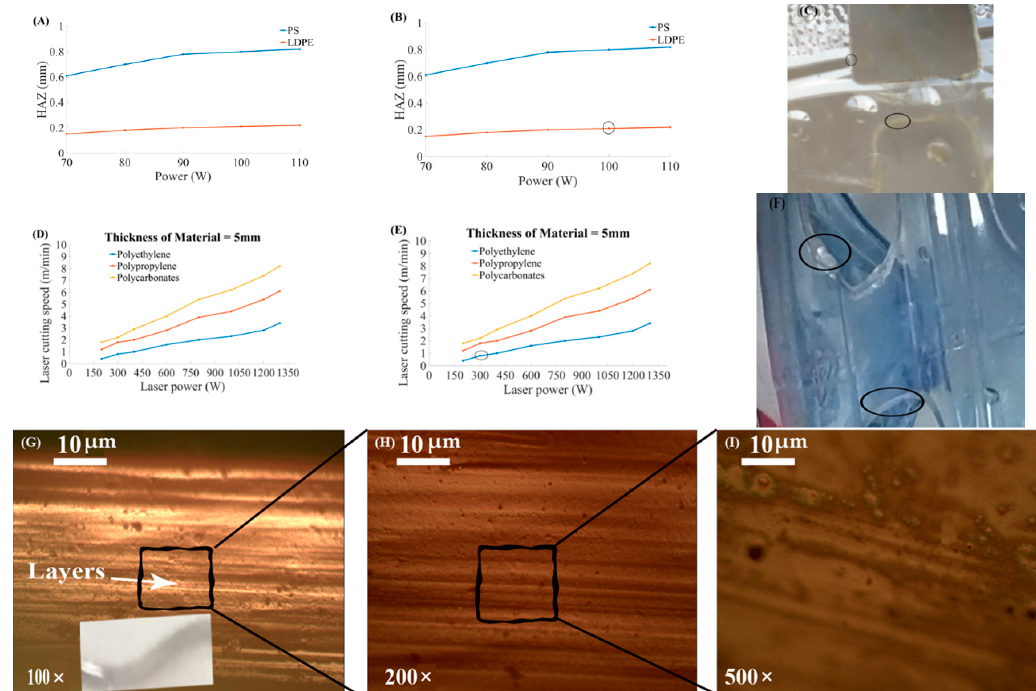
Figure 13. Parametric trends for P L and CS for PS, LDPE, PE, PP, and PC at different power ratings ( A ): Graphical illustration to show the influence of laser power on HAZ for PS and LDPE, ( B ) Indication of pointed part of ( A ), ( C ): Pictorial representation of one of the cut parts among PS and LDPE, ( D ): Relationship between laser power and cutting speed at same thickness of 5 mm for PE, PP, and PC, ( E ): Indication of pointed part from ( D ), ( F ): Pictorial representation of one of the cut parts among PE, PP, and PC ( G – I ): Microscopic examination of cut part at 100 × , 200 × , and 500 ×